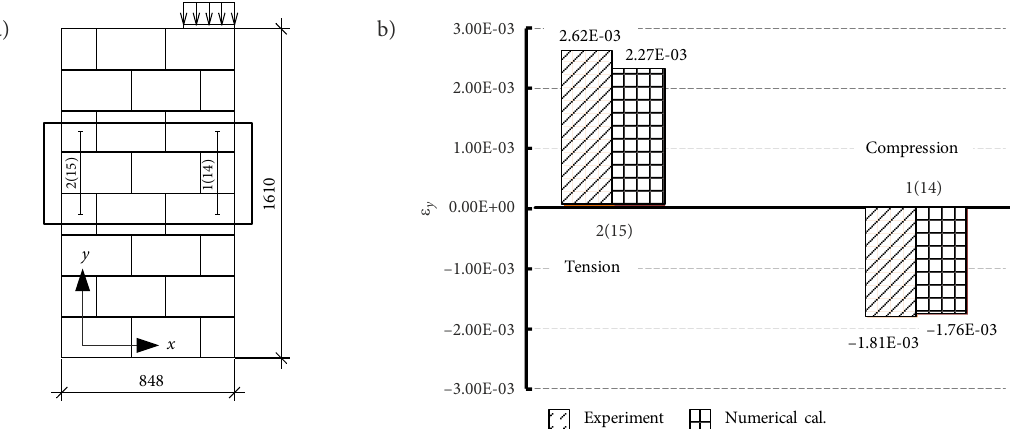
Figure 9. Strains in experiment and numerical model: a) test scheme; b) diagrams of strains